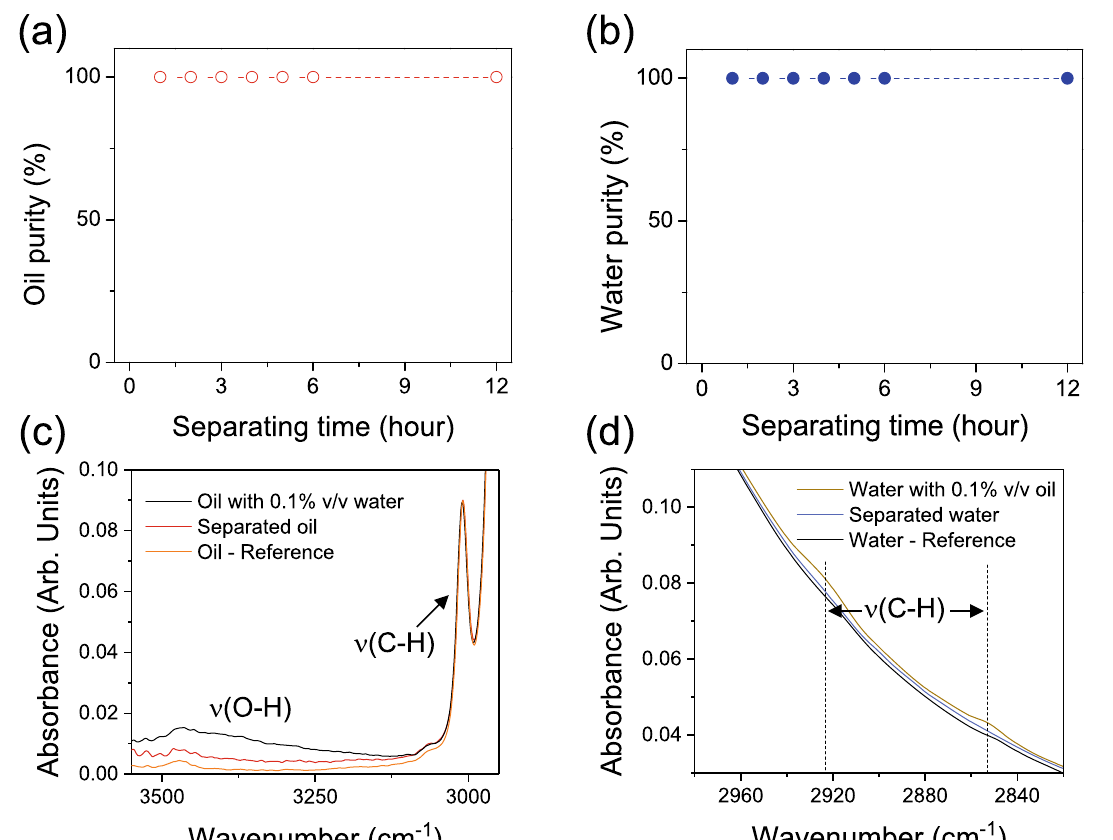
Figure 5. Purity of separated ( a ) oil and ( b ) water determined by distillation of liquids collected after separation time ranging from 0 to 12 h. ( c ) FTIR spectra comparison between separated oil (red line) and a 0.1%v/v water in oil reference solution (black line). ( d ) FTIR spectra comparison between separated water (blue line) and a 0.1%v/v oil in water reference solution (dark yellow